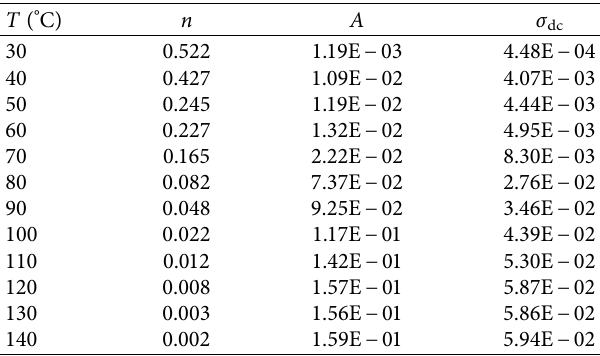
Table 5: Values of the exponent n , coefficient A , and the DC conductivity for pure 1 wt.% FeCl 2 PVA/PVP electrolyte blend sample.